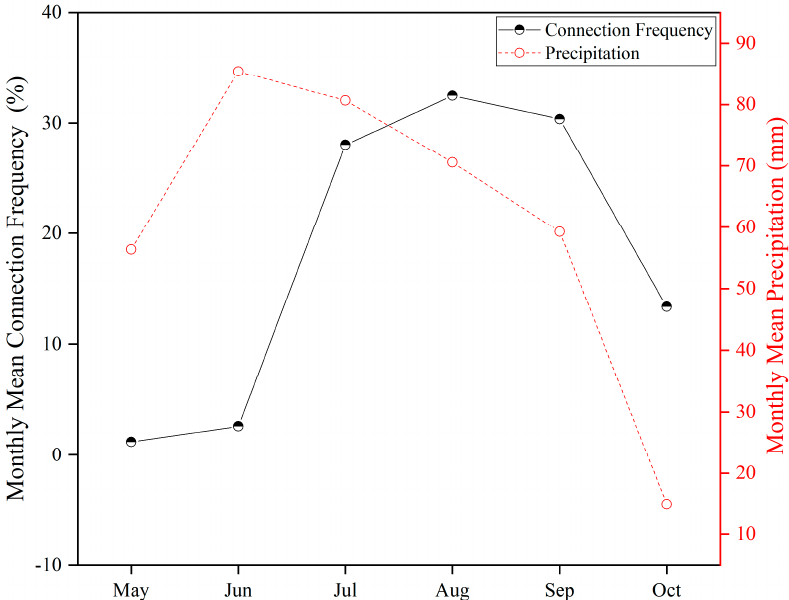
Figure 19. The relationship between monthly mean connection frequency and mean monthly precipitation in the Momoge National Nature Reserve, China from 2015 to 2019.